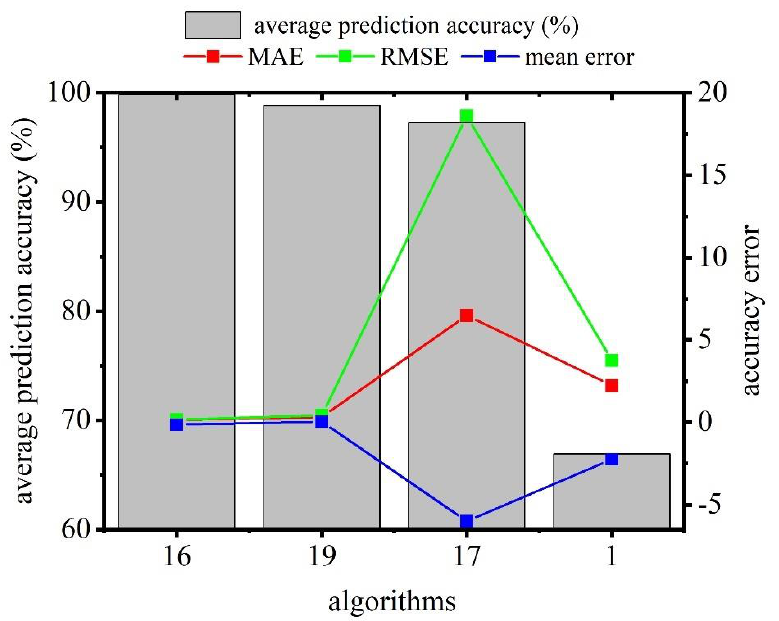
Figure 8. Comparison of the average prediction accuracy and actual accuracy of the four optimal algorithms, the numbers on the x-axis correspond to the algorithms in Table 3. The three algorithm quality indices for evaluation are MAE, RMSE, and mean error.